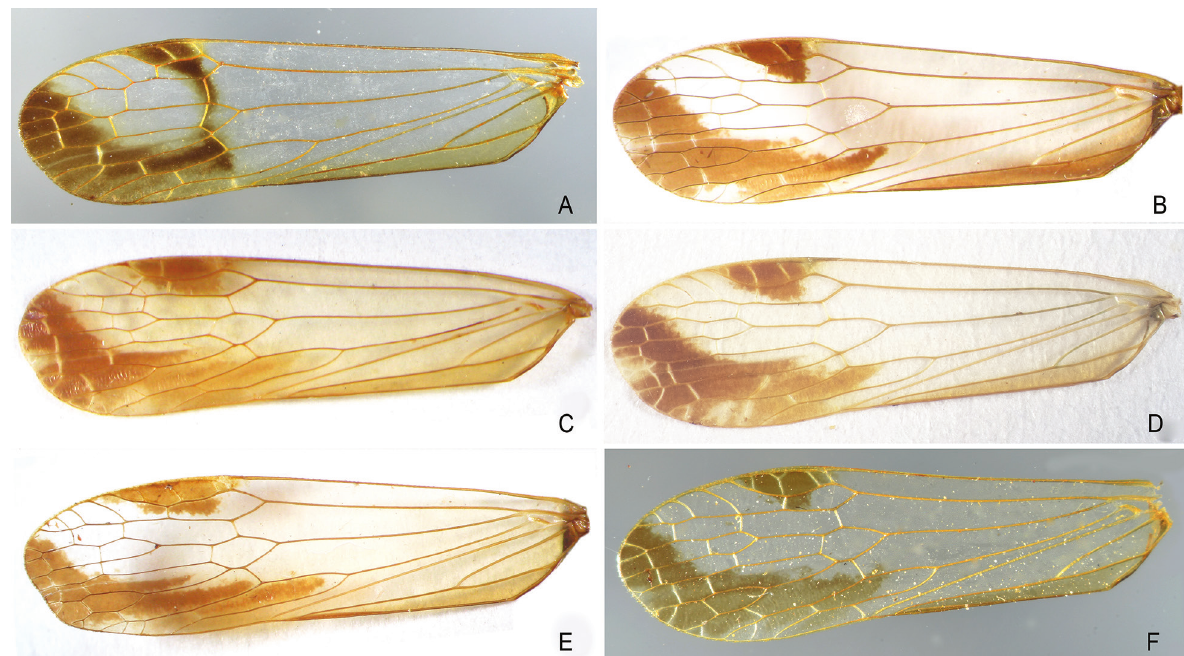
Figure 3. Forewing of Orthopagus species. ( A ) O. bartletti sp. n.; ( B ) O. exoletus (Melichar); ( C ) O. hainanensis sp. n.; ( D ) O. lunulifer Uhler; ( E ) O. philippinus Melichar; ( F ) O. splendens